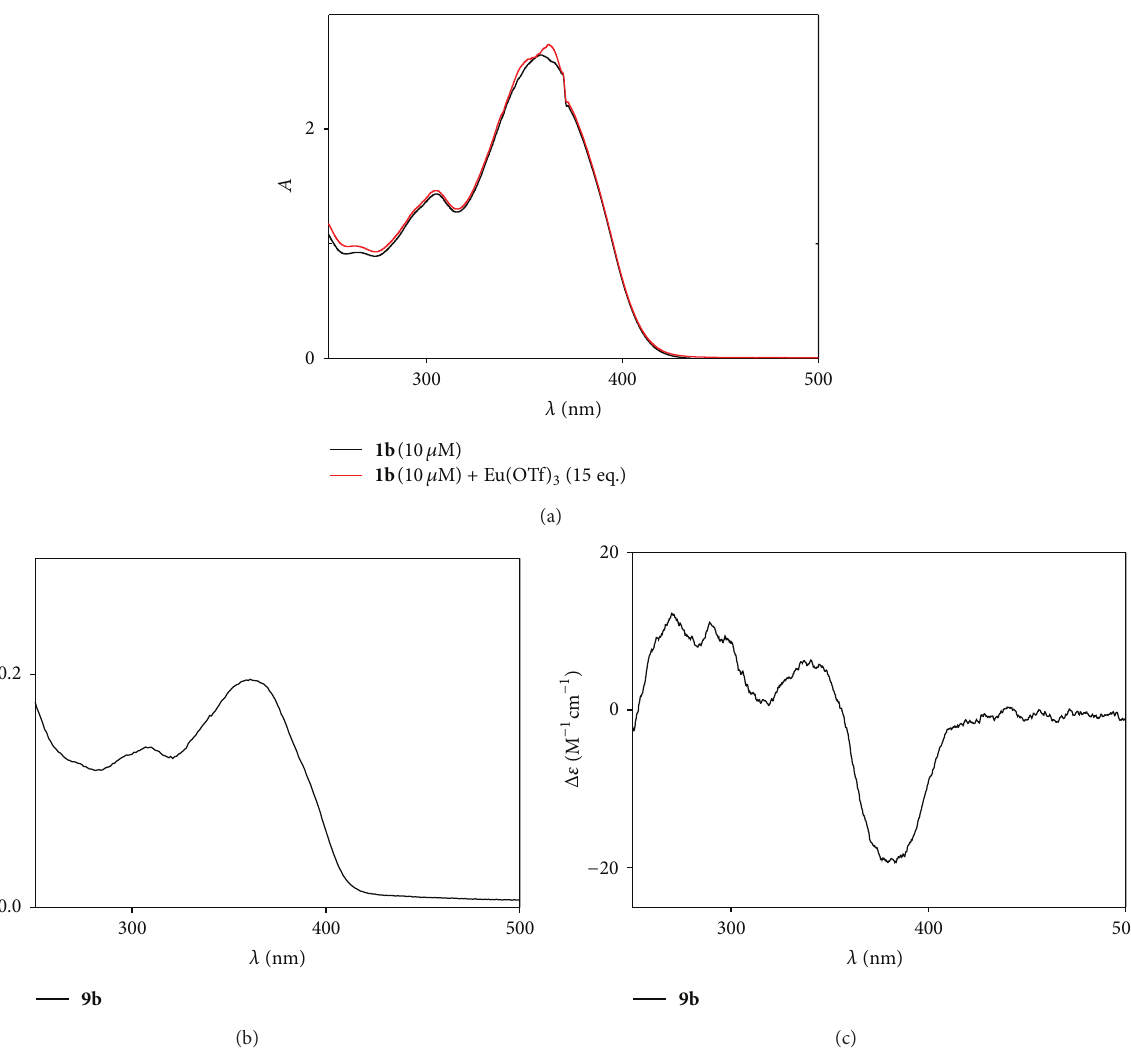
Figure 3: (a) Titration experiment of 1b with Eu(OTf) 3 in MeCN. ((b) and (c)) UV and CD spectra of 9b (1 𝜇 M,